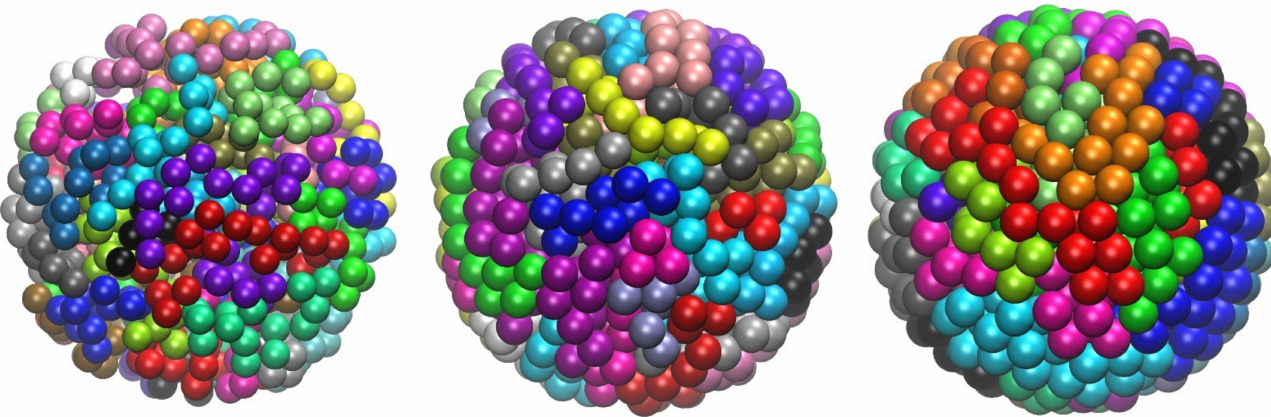
Figure 11. System snapshots of linear, fully flexible chains ( N ch = 60, N = 12) under spherical confinement at a packing density of (from left to right): ϕ = 0.30, 0.40 and 0.50. Monomers are colored according to the parent chain. Image created with the VMD visualization software [54]. Figure panels are also available as interactive, 3-D images in Supplementary